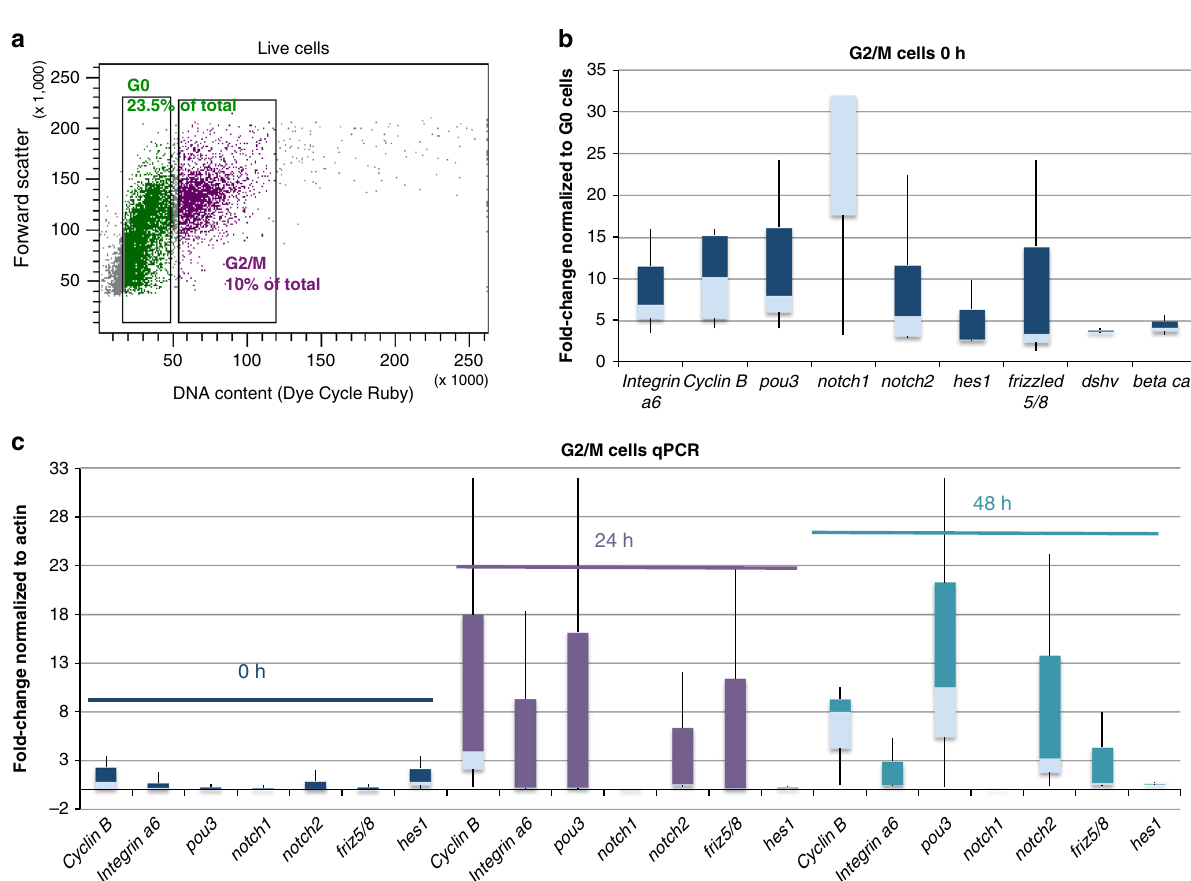
Fig. 5 Gene expression in cycling blood-borne cells in steady state and during WBR. a Isolation of cycling G2/M cells by fl ow cytometry. Cells were stained with the live DNA stain Dye Cycle Ruby. Linear analysis of fl uorescence intensity plotted against forward scatter (cell size) shows a clear separation of G2/M cells with 4n DNA content and G0/G1 cells with 2n DNA content. G2/M cells comprise 10% of live cells. b qPCR analysis showing expression of, integrin-alpha-6, cyclin b, pou3, notch1, notch2, hes1, frizzled 5/8, disheveled (dshv) , and beta catenin in G2/M cells in steady state (0 h). Data are expressed as fold changes normalized to G0 cells from three independent experiments. Box plot shows interquartile range (the distance between the upper and lower quartiles) and whiskers indicate the minimum and maximum of the data. c qPCR analysis showing expression of cyclin b, integrin-alpha-6, pou3, notch1, notch2 , and frizzled 5/8 in G2/M cells at 24 and 48 h post injury. Data are expressed as fold changes normalized to actin, from three independent experiments. Box plot shows interquartile range (the distance between the upper and lower quartiles) and whiskers indicate the minimum and maximum of the data. Source data are provided as a Source Data fi